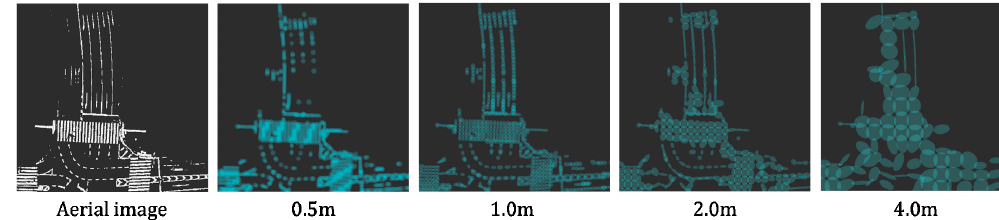
Figure 25. Generated Gaussian mixture models using different grid sizes.